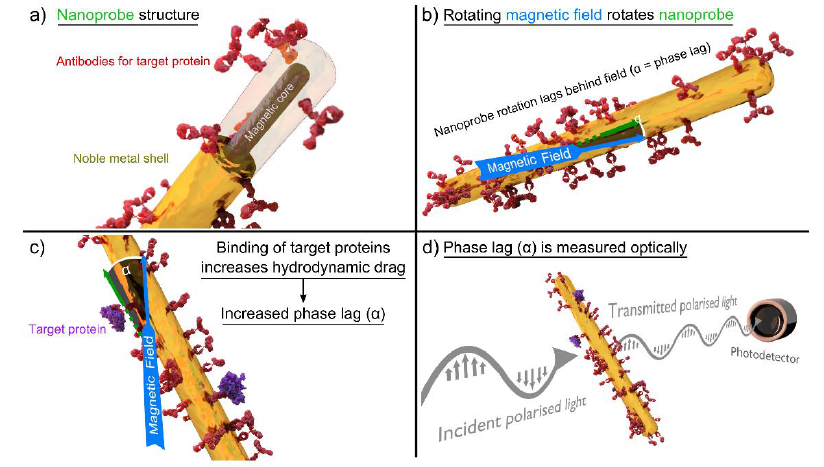
optical shape anisotropy: ( a ) Rod-shaped nanoprobe comprising a magnetic core and a noble metal shell with antibodies on the particle surface for specific binding of target proteins; ( b ) The ferromagnetic nanorod follows the applied rotating magnetic field (RMF) with a phase lag α due to the drag torque experienced in the sample solution, which depends on the hydrodynamic nanoprobe volume; ( c ) Binding of target proteins increases the hydrodynamic drag and, consequently, the phase lag α ; ( d ) The transmission of linearly polarized light is detected. Its intensity directly relates to the actual orientation of the nanoprobe with respect to the polarization direction (angle α ). Comparison of the optical signal with the momentary orientation of the RMF allows deduction of the angle α . Reprinted with permission from [291]. Copyright 2016, American Chemical